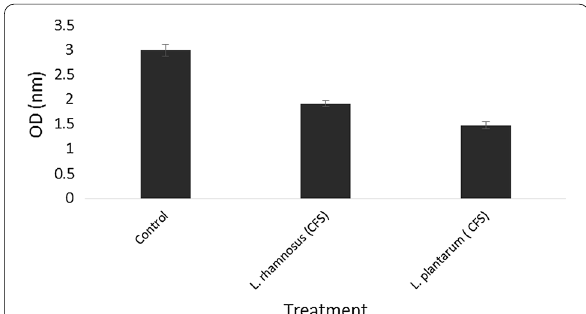
Fig. 2 Antagonistic activity of the cell-free supernatant on L. monocytogenes